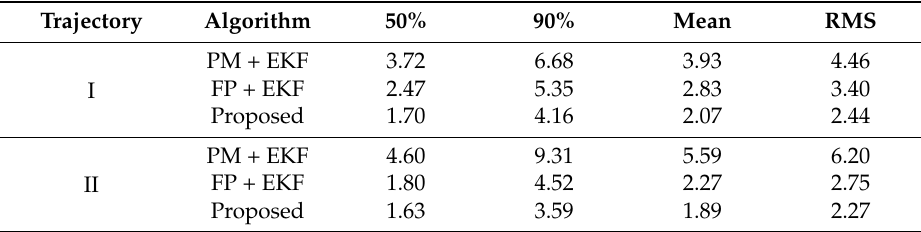
Table 2. Summary of localization errors of the two trajectories in the case of sparse distribution of BLE beacons (m).